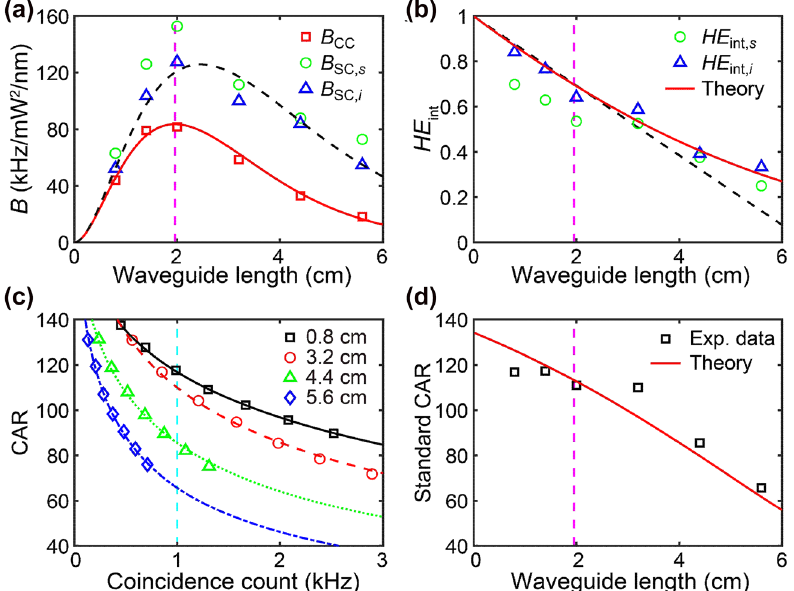
Figure 2: Measured brightness and CAR with a 300-GHz detuned frequency. (a) Brightness against the waveguide length. The red squares ( B ), and blue triangles ( B ) are the experimental data. The theoretical fit using Eqs. (11) and (12) are shown as solid red and dashed black circles ( B SC , s SC , i lines, respectively, atop the experimental data. (b) The intrinsic heralding efficiency against the waveguide length. The green circles ( HE ) are the experimental data. The theoretical fit using Eq. (13) is shown as solid red atop the experimental data, and the dashed black triangles ( HE int , i ≈ 1 − 0.3 𝛼 L for L ≤ 1 ∕ 𝛼 . (c) The CAR against the measured coincidence counts for various waveguide lengths curve is the linear approximation of HE int [0.8 cm, 3.2 cm, 4.4 cm, and 5.6 cm]. The symbols are the experimental data for various waveguide lengths. The theoretical fit using Eq. (15) is shown as solid black, dashed red, dotted green, and dashed-dotted blue atop the experimental data. The vertical dashed cyan line shows where N (d) Standard CAR against the waveguide length. The black square represents experimental data. The theoretical fit (solid red) is obtained using Eq. (15) = 1 kHz in (c). The dashed magenta lines in (a), (b), and (d) show where L = 1 ∕ 𝛼 ≈ 1.96 with g = 3972 HZ 1 ∕ 2 and the extracted CAR value at N CC